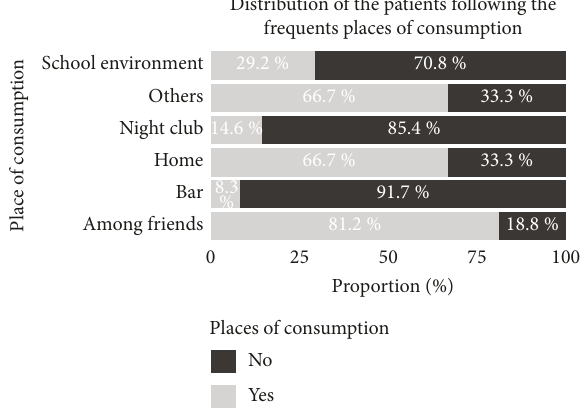
Figure 2: Distribution of the subjects according to locations of cannabis consumption.